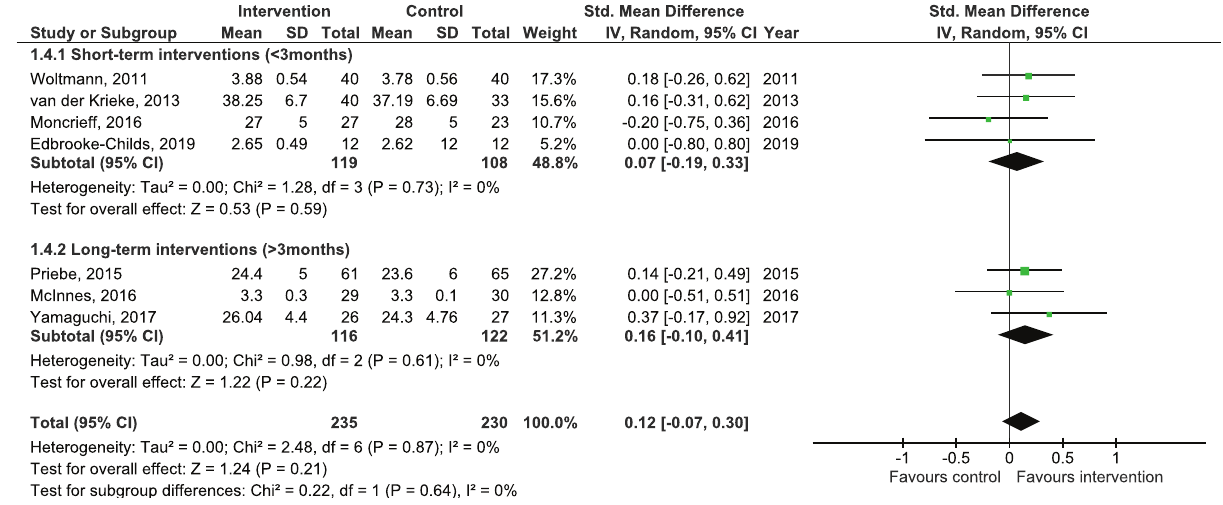
FIGURE 6 | Forest plot for patient satisfaction by duration.